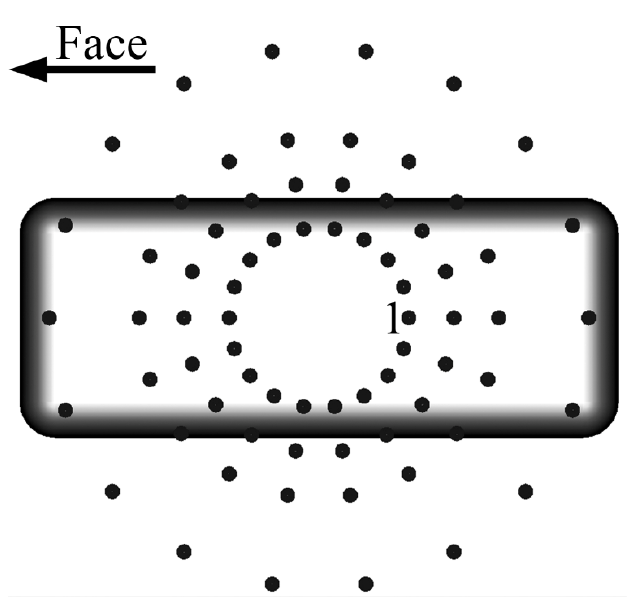
Figure 22. Location of spatial readings in which EMF (electromagnetic field) was recorded relative to the phone case.